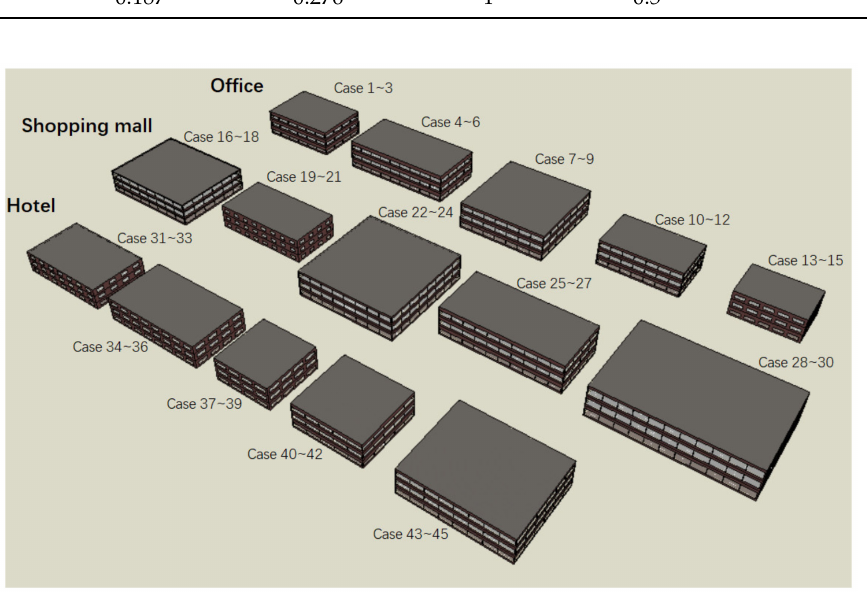
Figure 12. Building models of 45 test